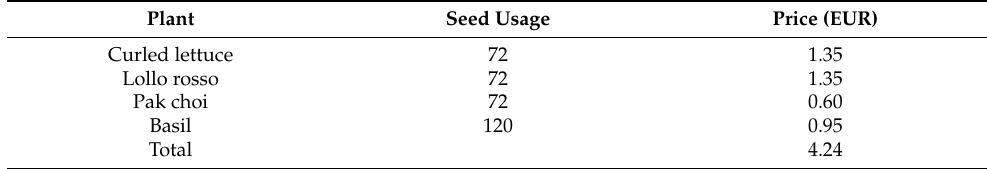
Table 2. Overview of the SOF inputs (number of crops and seeds). Plant